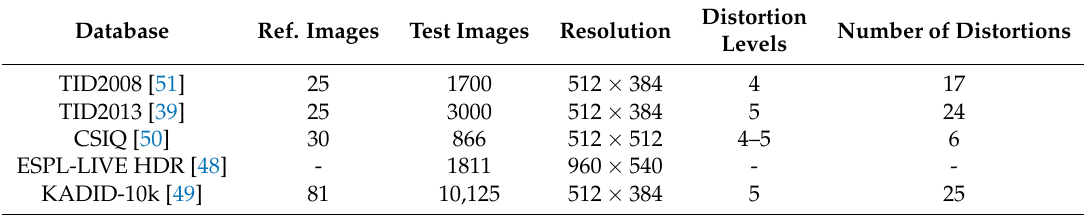
Table 2. Comparison of publicly available IQA databases used in this